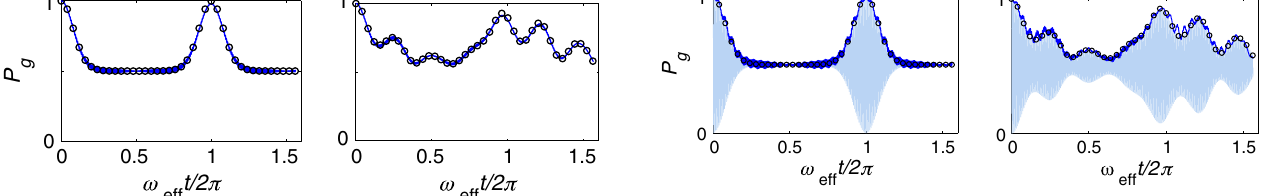
ð t Þ obtained by integrating the exact (solid line) FIG. 1. P g equation, (3), and the effective (circles) Hamiltonian equation, (6). With the set of parameters in the text, (cid:1) 1 ¼ 2 (cid:2) (cid:6) 700 MHz , we have two cases: left panel: (cid:1) 2 ¼ 0 , right panel: (cid:1) 2 ¼ 2